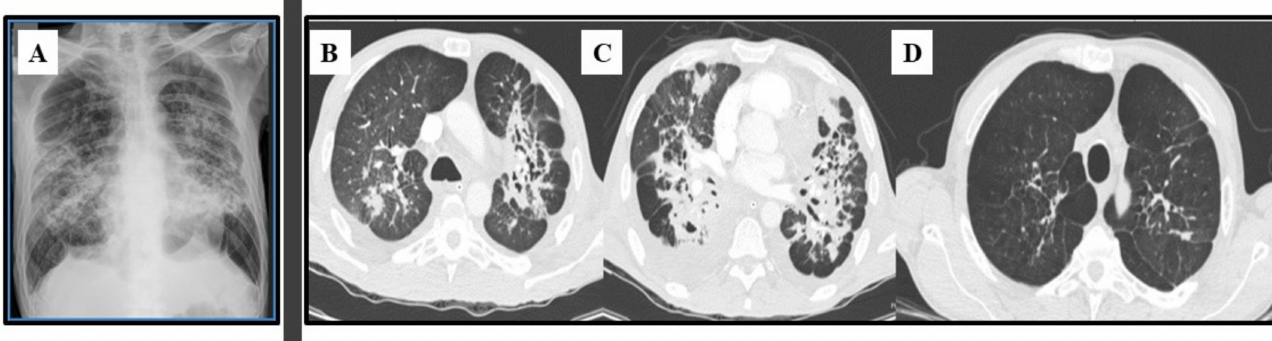
Figure 6. Lung images of a 53-year-old male patient with chronic paracoccidioidomycosis. ( A ) Plain chest radiograph with bilateral, parahilar, and symmetrical interstitial alveolar infiltrate (“butterfly wing” pattern); ( B , C ) Axial thoracic CT at diagnosis with multiple bronchiectasis associated with areas of irregular parenchymal opacities, and diffuse nodules (some of them excavated); ( D ) Axial thoracic CT at the end of antifungal therapy: areas of emphysema with traction bronchiectasis, retractable striae, and central architectural distortion, predominantly peribronchovascular, indicating